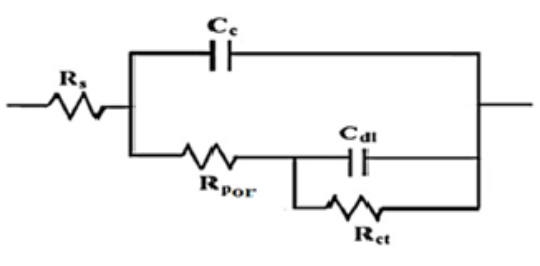
Fig 10. Equivalent circuit